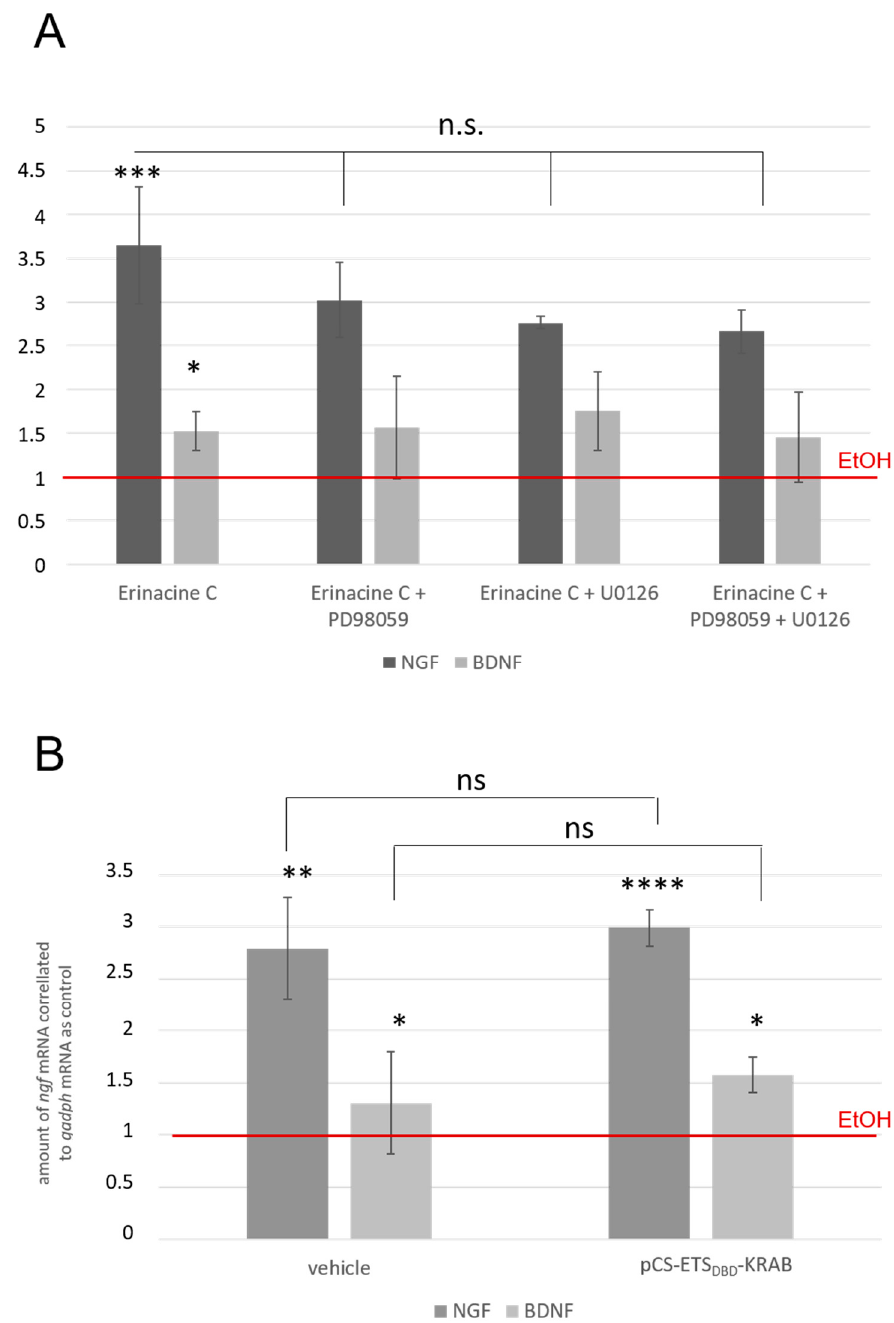
Figure 7. Erinacine C likely activates ETS signaling independent of inducing neurotrophin expression. ( A ) Fold-activation of ngf (dark grey) and bdnf (light grey) transcription in 1321N1 cells treated for 48 h with erinacine C in the presence of MAPKK (20 µ M PD98059) and ERK1 / 2 (10 nM U0126) inhibitors compared to gapdh mRNA analyzed by semiquantitative RT-PCR. Values from 0.5% EtOH treated cells were used as control and were set as one (red line). Stars indicate a significant upregulation compared to EtOH controls. ( B ) Fold-activation of ngf (dark grey) and bdnf (light grey) expression by semiquantitative RT-PCR from 1321N1 cells electroporated either with the pBluescriptII vector (vehicle) or the pCS-ETS1 DBD -KRAB construct (KRAB) expressing a constitutive inhibitor of ETS signaling. A total of 24 h after transfection cells were exposed to erinacine C (5 µ g / mL) or EtOH (0.5%) for 48 h. The latter served as control with its ngf : gapdh ratio set as one (marked as red line) (three independent cultures). ns: not significant; * p < 0.05, ** p < 0.01, *** p < 0.001, **** p < 0.0001.